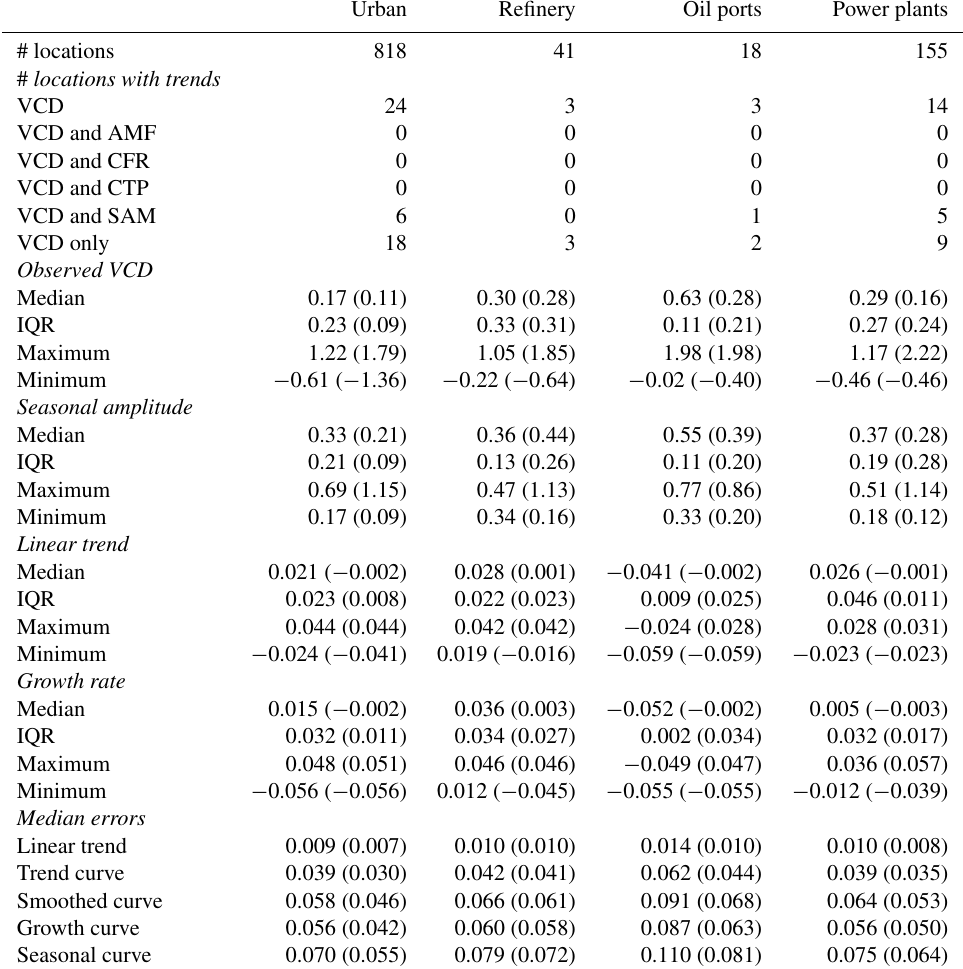
Table 3. Statistical summary of the NASA SO 2 vertical column density (VCD) analysis conducted at an approximate 10km radius over the target locations. Statistical values are shown for those locations which have a real VCD trend, i.e. those locations without a corresponding trend in either the cloud fraction (CFR), cloud-top pressure (CTP), or number of samples (SAM). Values in parentheses correspond to statistics for all locations of a given category. VCD values are given in DU, and IQR is the interquartile